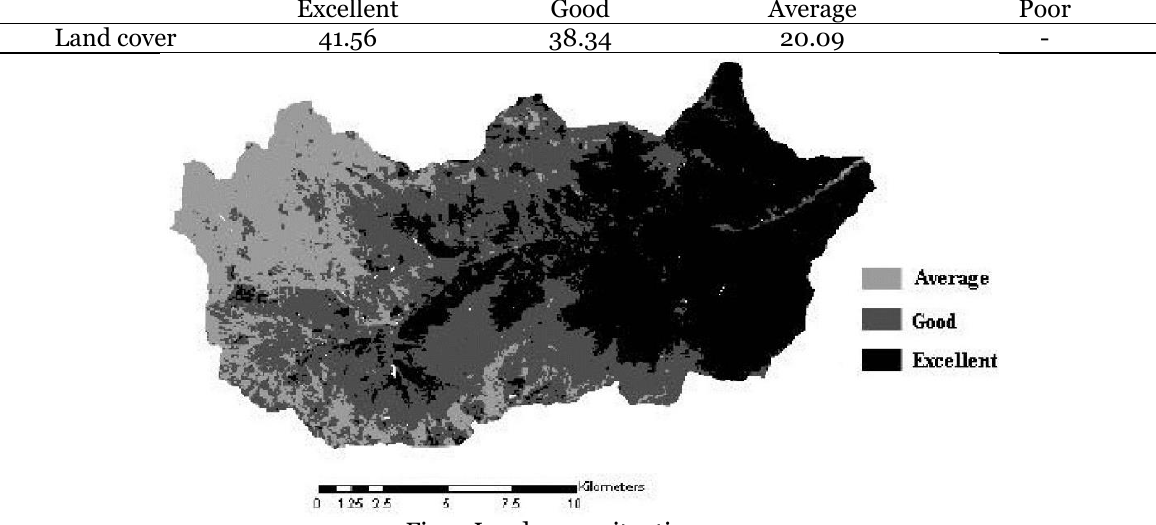
Fig.3. Land cover situation